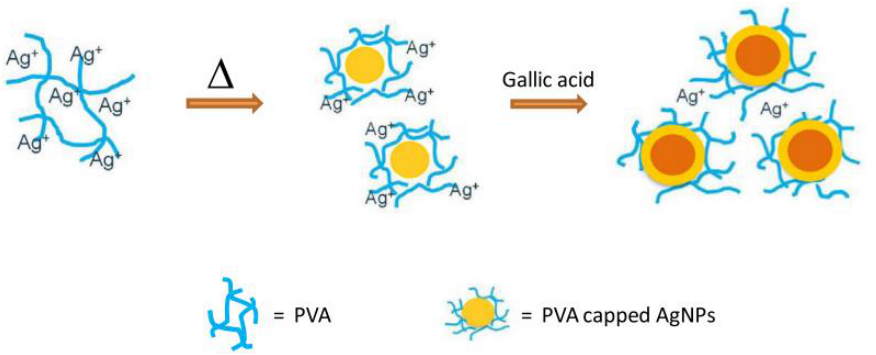
Figure 17. Schematic representation of the synthesis of PVA-AgNPs nanoantioxidant hybrids. Reprinted (adapted) with permission from [103].